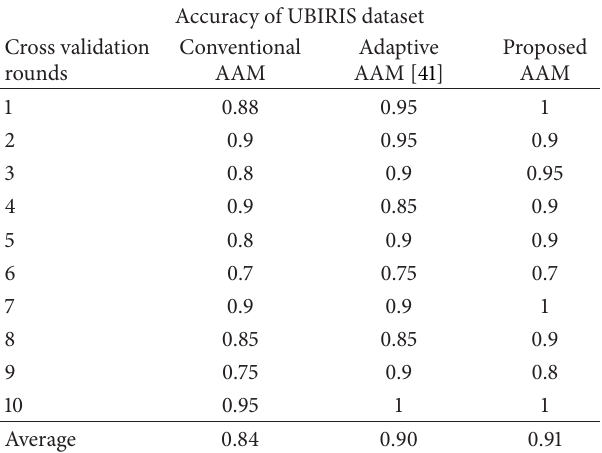
Table 5: Cross validation results for UBIRIS dataset in terms of accuracy for conventional AAM, adaptive AAM, and the proposed AAM.